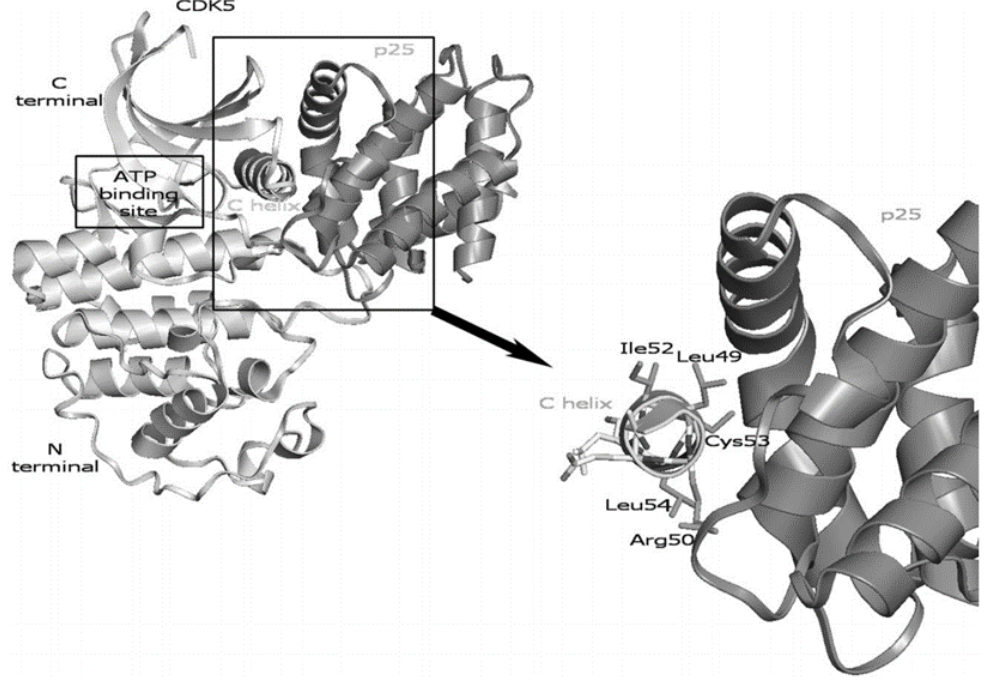
Figure 5. The overall 3D structure of CDK5/p25 is on the left. The right side of the figure depicts a closeup of the C helix bound to p25. Adapted with permission[27].